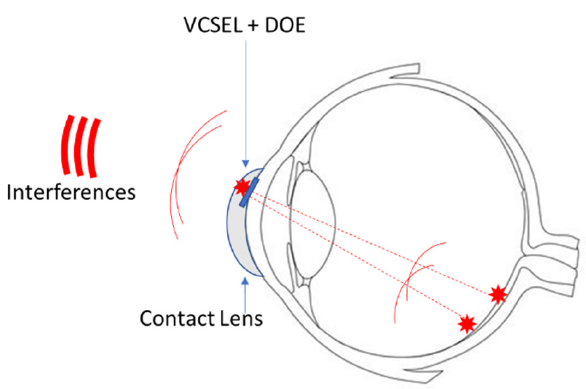
Figure 8. Refractive error measurement by interferometric method.